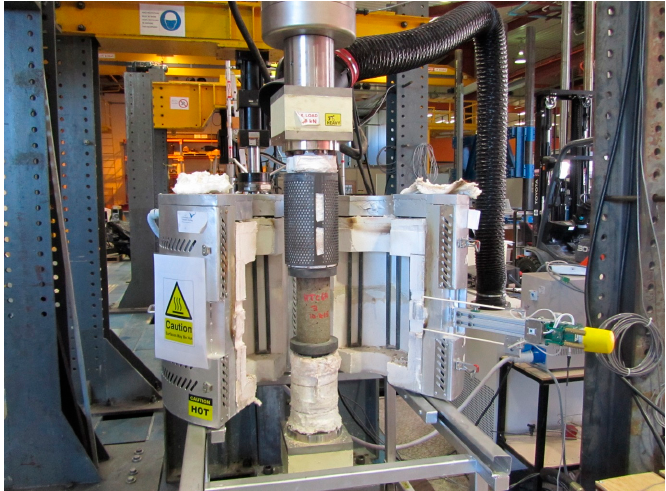
Figure 1. High temperature testing arrangement.